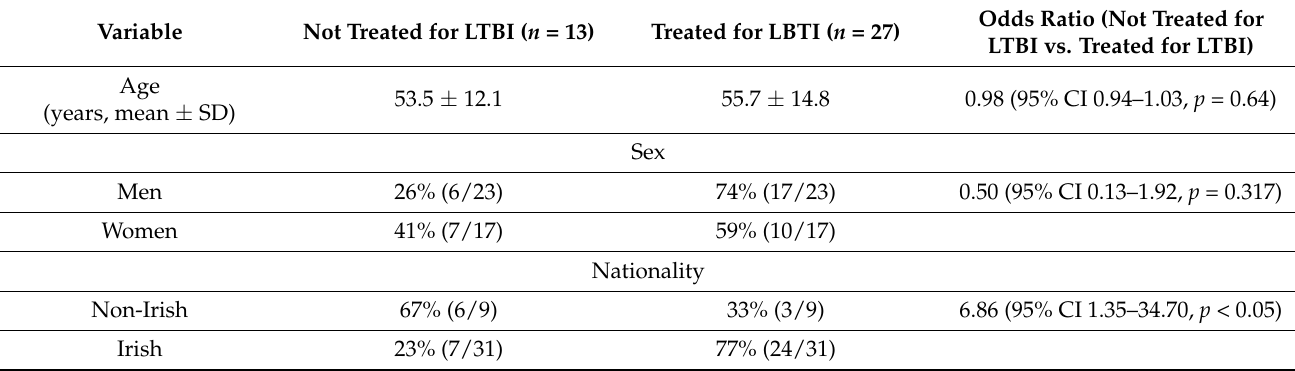
Table 2. Predictors of not being treated for latent tuberculosis